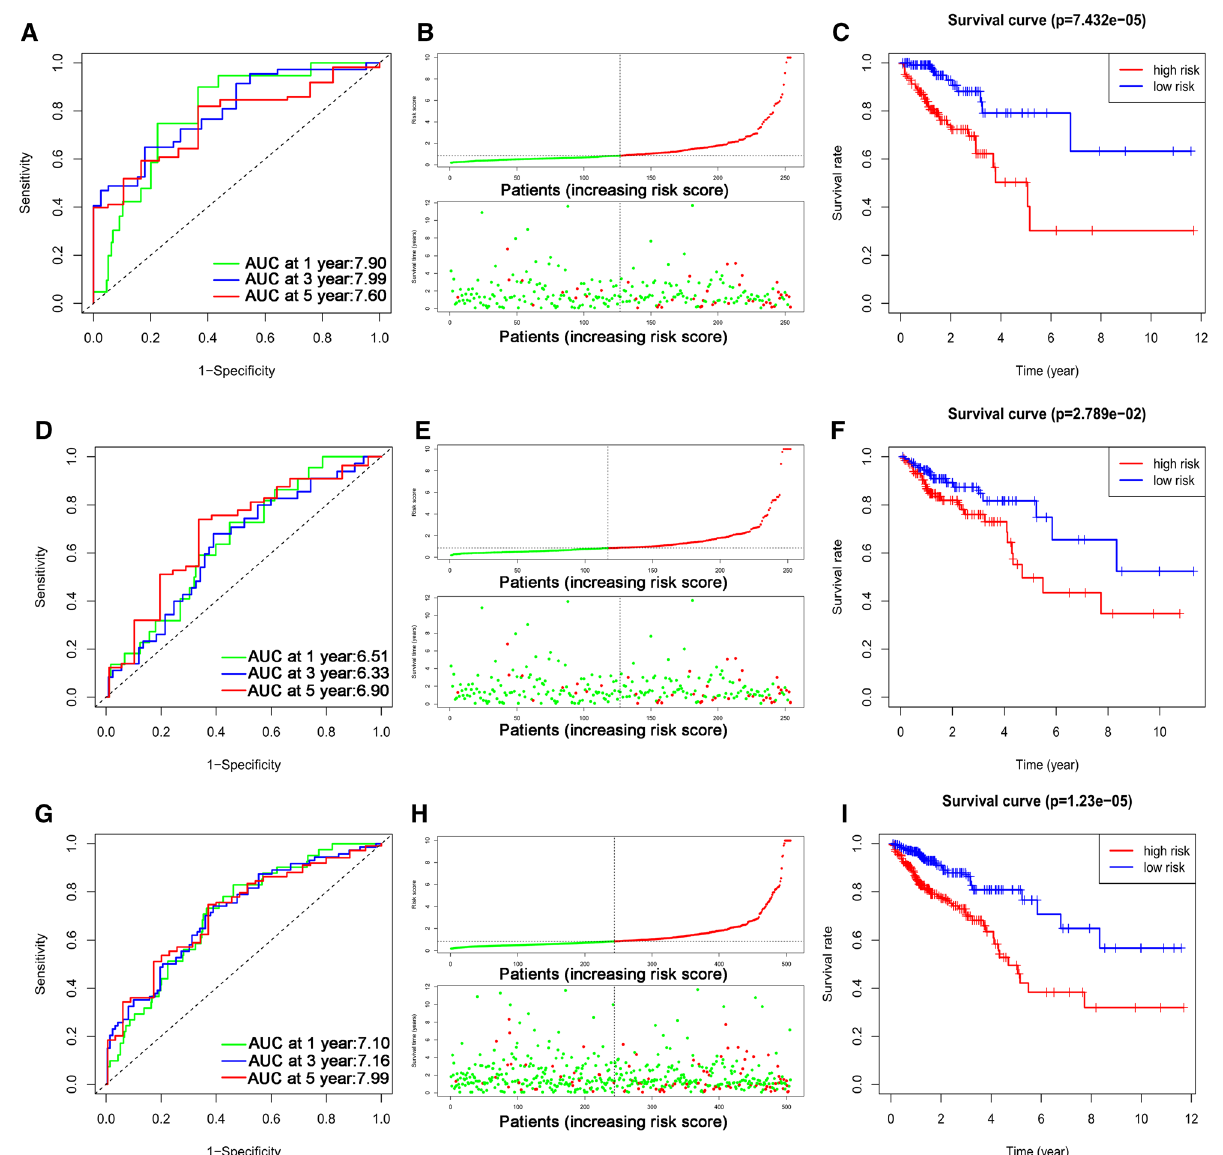
Figure 2. The prognostic value of the immune-related lncRNA signature. ( A ) Time-dependent ROC curve analysis, ( B ) risk score and vital status, and ( C ) Kaplan–Meier survival curve of the immune-related lncRNA signature in the training cohort. ( D ) Time-dependent ROC curve analysis, ( E ) risk score and vital status, and ( F ) Kaplan–Meier survival curve of the immune-related lncRNA signature in the test cohort. ( G ) Time-dependent ROC curve analysis, ( H ) risk score and vital status, and ( I ) Kaplan–Meier survival curve of the immune-related lncRNA signature in the entire TCGA